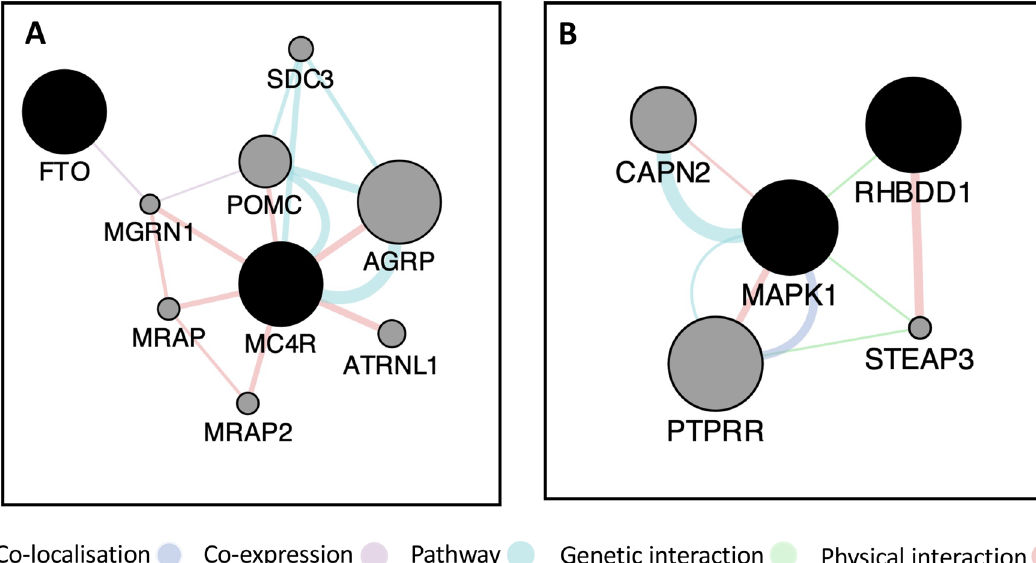
Figure 2. Gene networks. Nodes depicting genes are connected by edges formed on the basis of evidence for physical interaction (red), pathway (blue), co-expression (purple), co-localisation (violet) and genetic interaction (green). The maps for the detected interaction pairs are as follows: ( A ) rs1121980-rs6567160, ( B ) rs2177596-rs17759796. The solid black nodes are the query genes and the grey nodes are the resultant